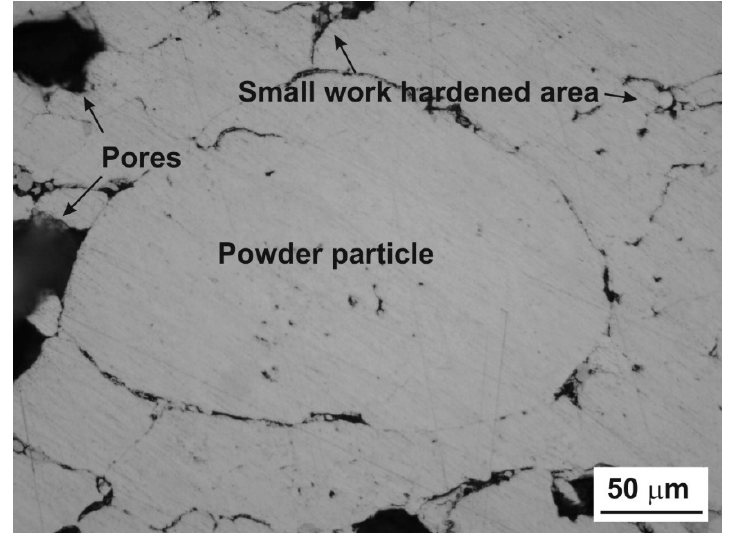
Figure 4. Typical microstructural overview for low pressure.